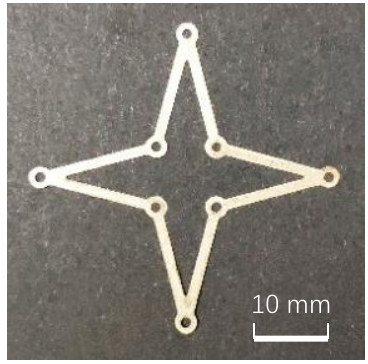
Figure 7. Finished leaf springs.